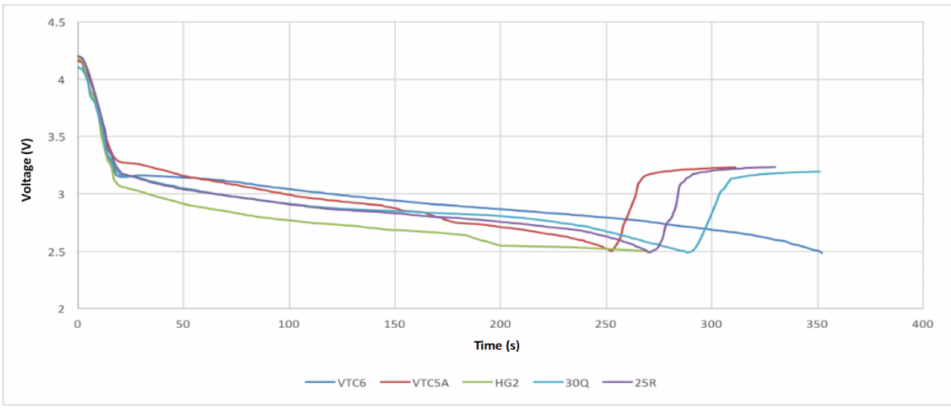
Figure 10. Single cell tests: voltages from 30 A discharge with active air cooling.